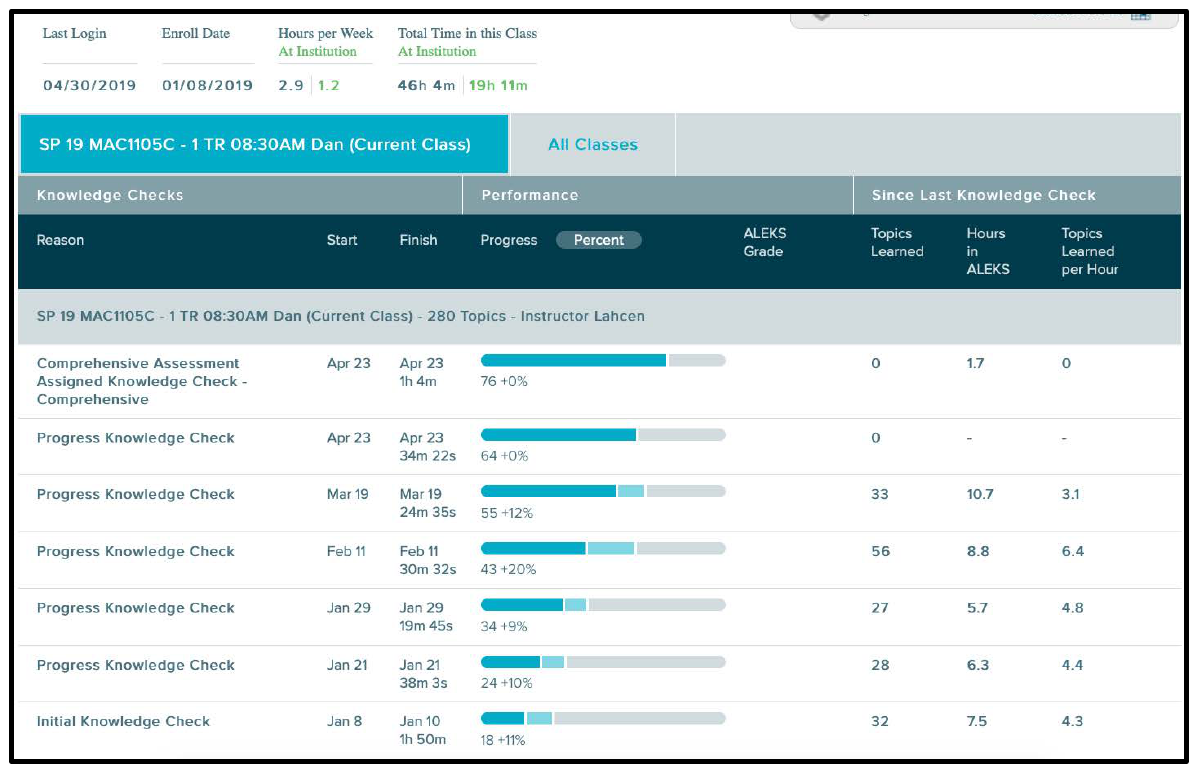
Figure 8a. Progress report (ALEKS) shows student progress knowledge checks, topics learned, hours in the system, and learning rate. Adapted from MAC1105C: College Algebra , by R. Ait Maalem Lahcen, 2019, Orlando, FL: University of Central Florida. Copyright 2019 by the University of Central